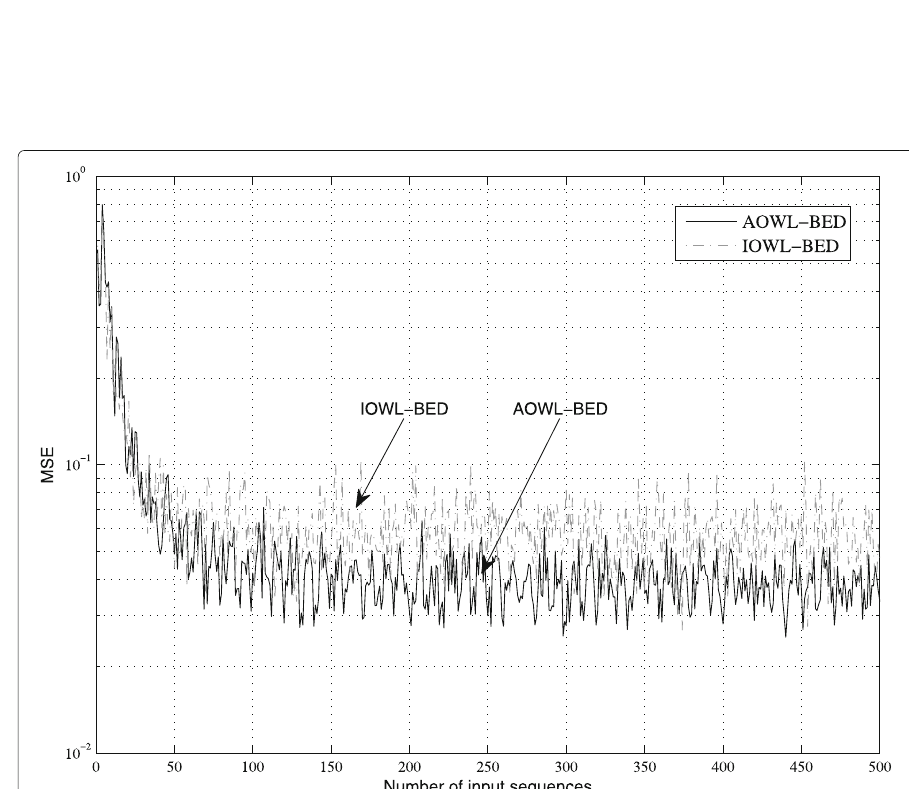
Fig. 5 Convergence performance comparison of VOWL-BED and IOWL-BED at SNR = 15